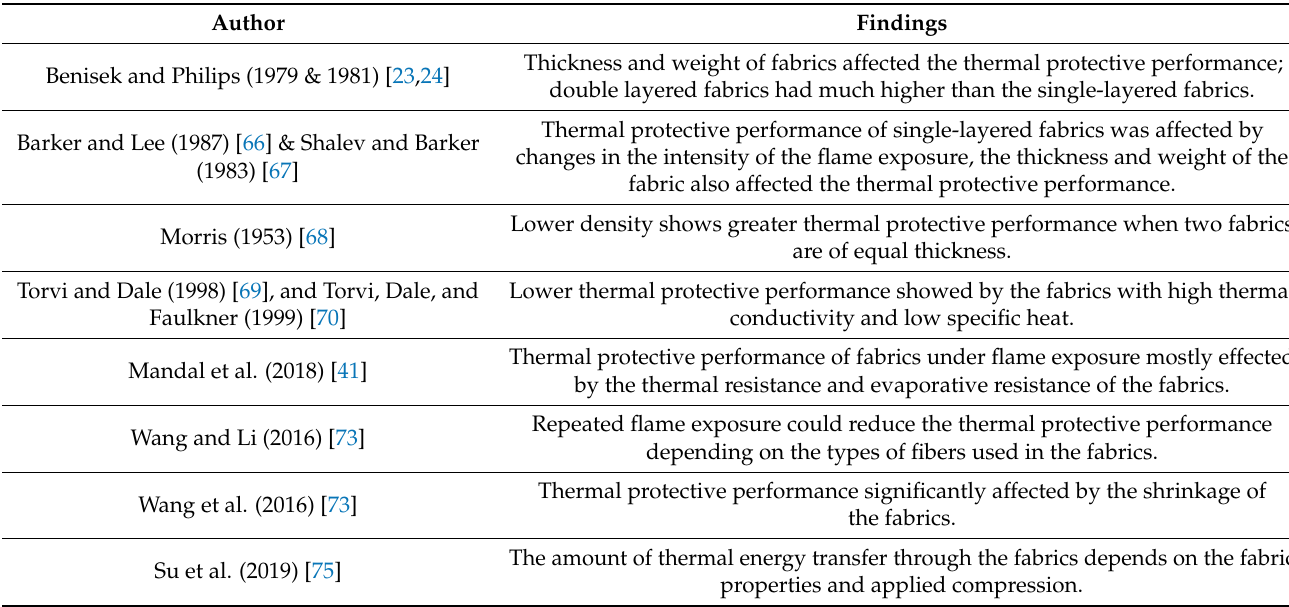
Table 1. Thermal protective performance under flame